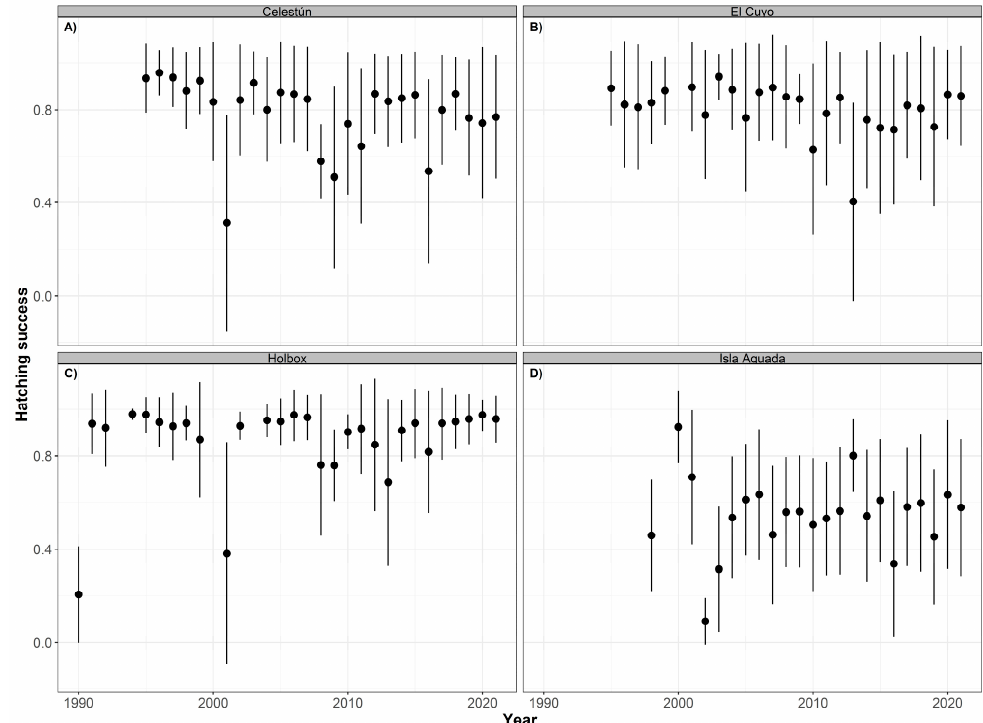
Figure 8. Time series of hatching success (annual mean ± SD) for hawksbill turtles ( Eretmochelys imbricata ) nesting at Celestún ( A ), El Cuyo ( B ), Holbox ( C ), and Isla Aguada ( D ) from 1990 to 2021.